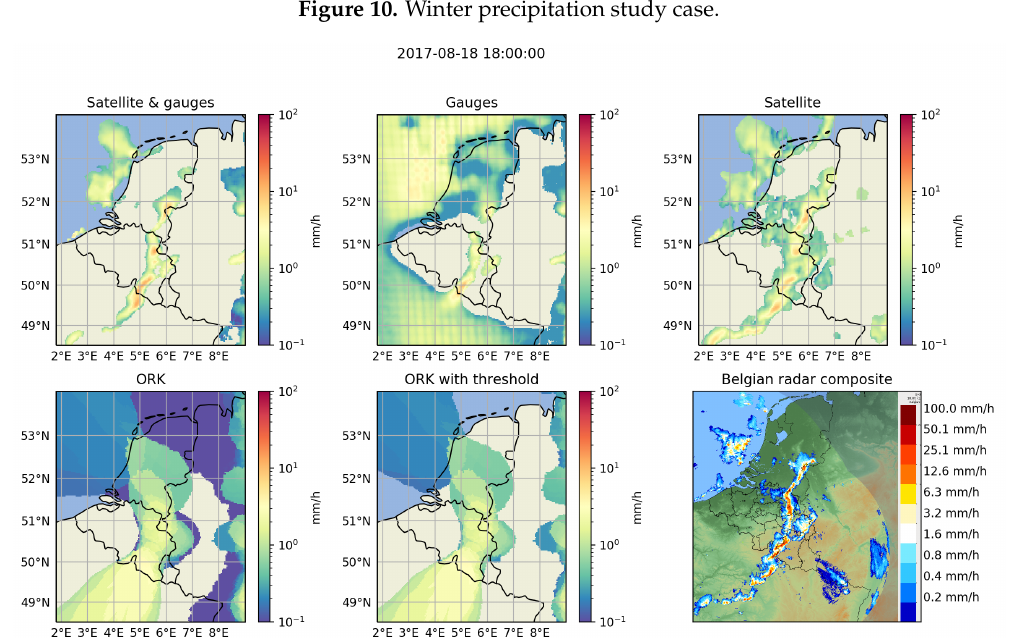
Figure 10. Winter precipitation study case.